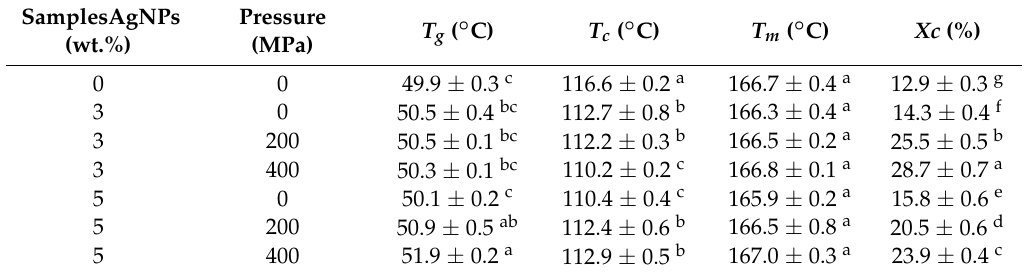
Table 2. Effect of high pressure treatment on the mechanical property of PLA/AgNPs nanocomposite films. SamplesAgNPs